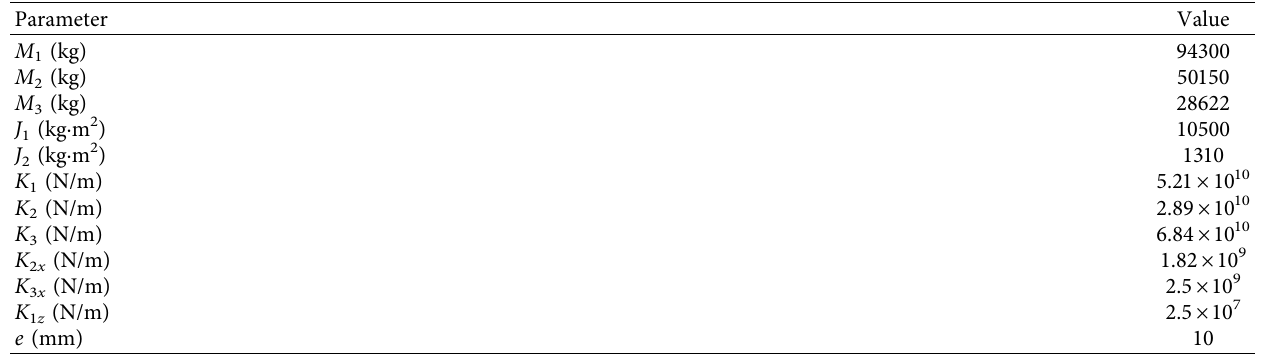
Table 2: Structural and technological parameters of the 1580 hot rolling